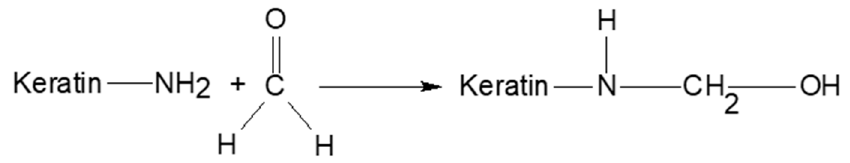
Figure 1. Keratin chemisorption reaction.